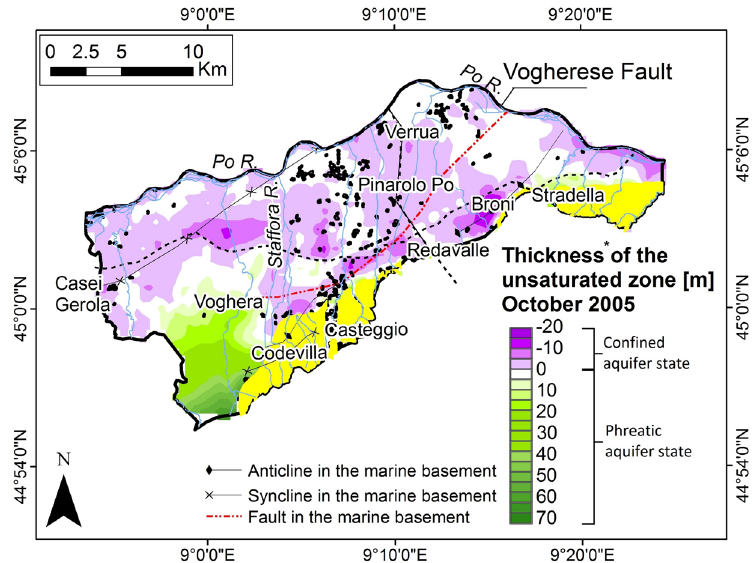
Figure 9. Thickness of the unsaturated zone in October 2005 (modified from Pilla et al., 2007), and superimposed ground motion areas detected via PC3 of the Radarsat data (black box). The pre-Würmian deposits are represented in yellow.